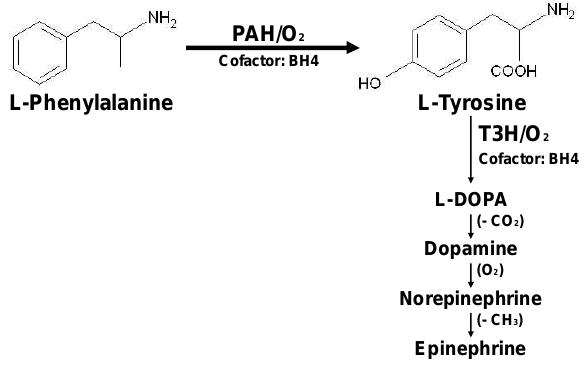
Figure 1. Biochemistry of L-phenylalanine: L-Phenyl- alanine is an essential proteinogenic amino acid and also a precursor of biogenic amines. Phenylalanine 4- hydroxylase (PAH, EC 1.14.16.1) is the rate-limiting enzyme, which introduces a hydroxy-group to pheny- lalanine to form L-tyrosine. L-tyrosine is further con- verted to L-3,4-dihydroxyphenylalanine (L-DOPA) by tyrosine 3-hydroxylase (T3H, EC 1.14.16.2). Both enzymes, PAH and T3H, require 5,6,7,8-tetrahydro- biopterin (BH ) as a cofactor. Tyrosine is then metab- 4 olized to the catecholamines dopamine, norepineph- rine (noradrenaline), and epinephrine